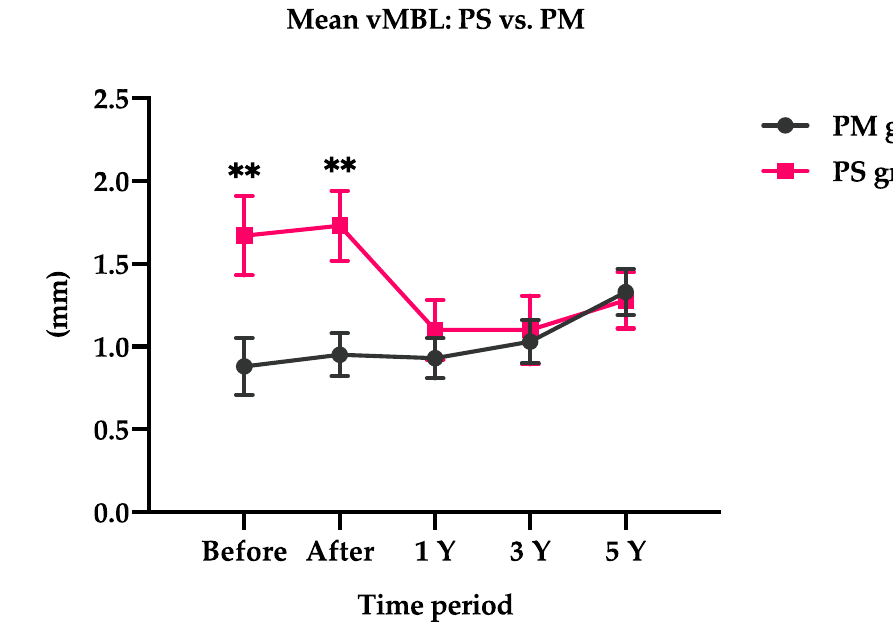
Figure 3. Comparison of mean vMBL between the PS and PM groups. PS, platform-switched dental implants; PM, platform-matched dental implants; vMBL, vertical marginal bone level. ** p < 0.01. Interestingly, a similar MBL trend was observed in the PM and PS groups. The MBL in the PM group increased from 1 year after loading, whereas the MBL in the PS group decreased immediately after loading (Figure 4). Over time, PS dental implants were more likely to gain bone, whereas PM dental implants were more likely to lose bone during the observation time, and the MBL after 5-year loading was significant between the PM and PS groups, with 1.04 ± 0.43 mm and 0.76 ± 0.54 mm ( p = 0.036), respectively.